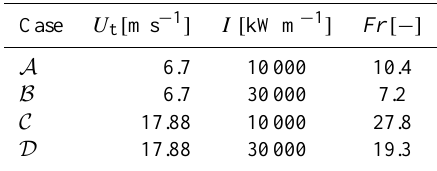
Table 2. Values of the mean wind velocity, U t , of the fire inten- sity, I , and of the Fr number for the four cases for which numerical results are presented here. These values correspond to the same sys- tem configurations considered by Sardoy et al.